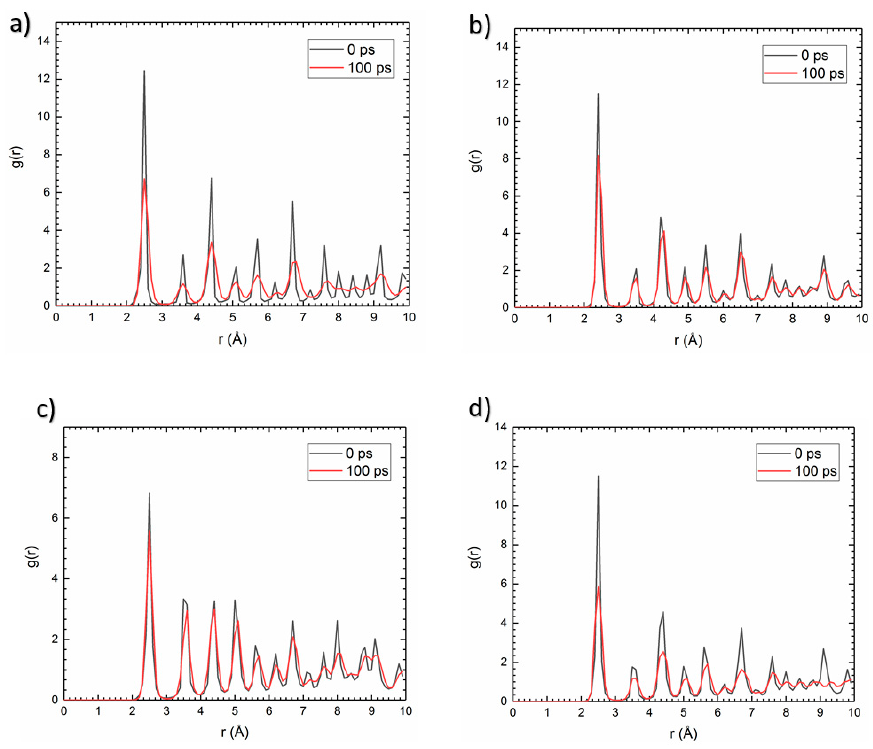
Figure 11. Radial distribution function in the precipitate ( a ) Cu-Cu atom pairs in copper, ( b ) Ni-Ni atom pairs in nickel, ( c ) Cu-Cu atom pairs in equimolar Cu-Ni alloy, ( d ) Ni-Ni atom pairs in equimolar Cu-Ni alloy.